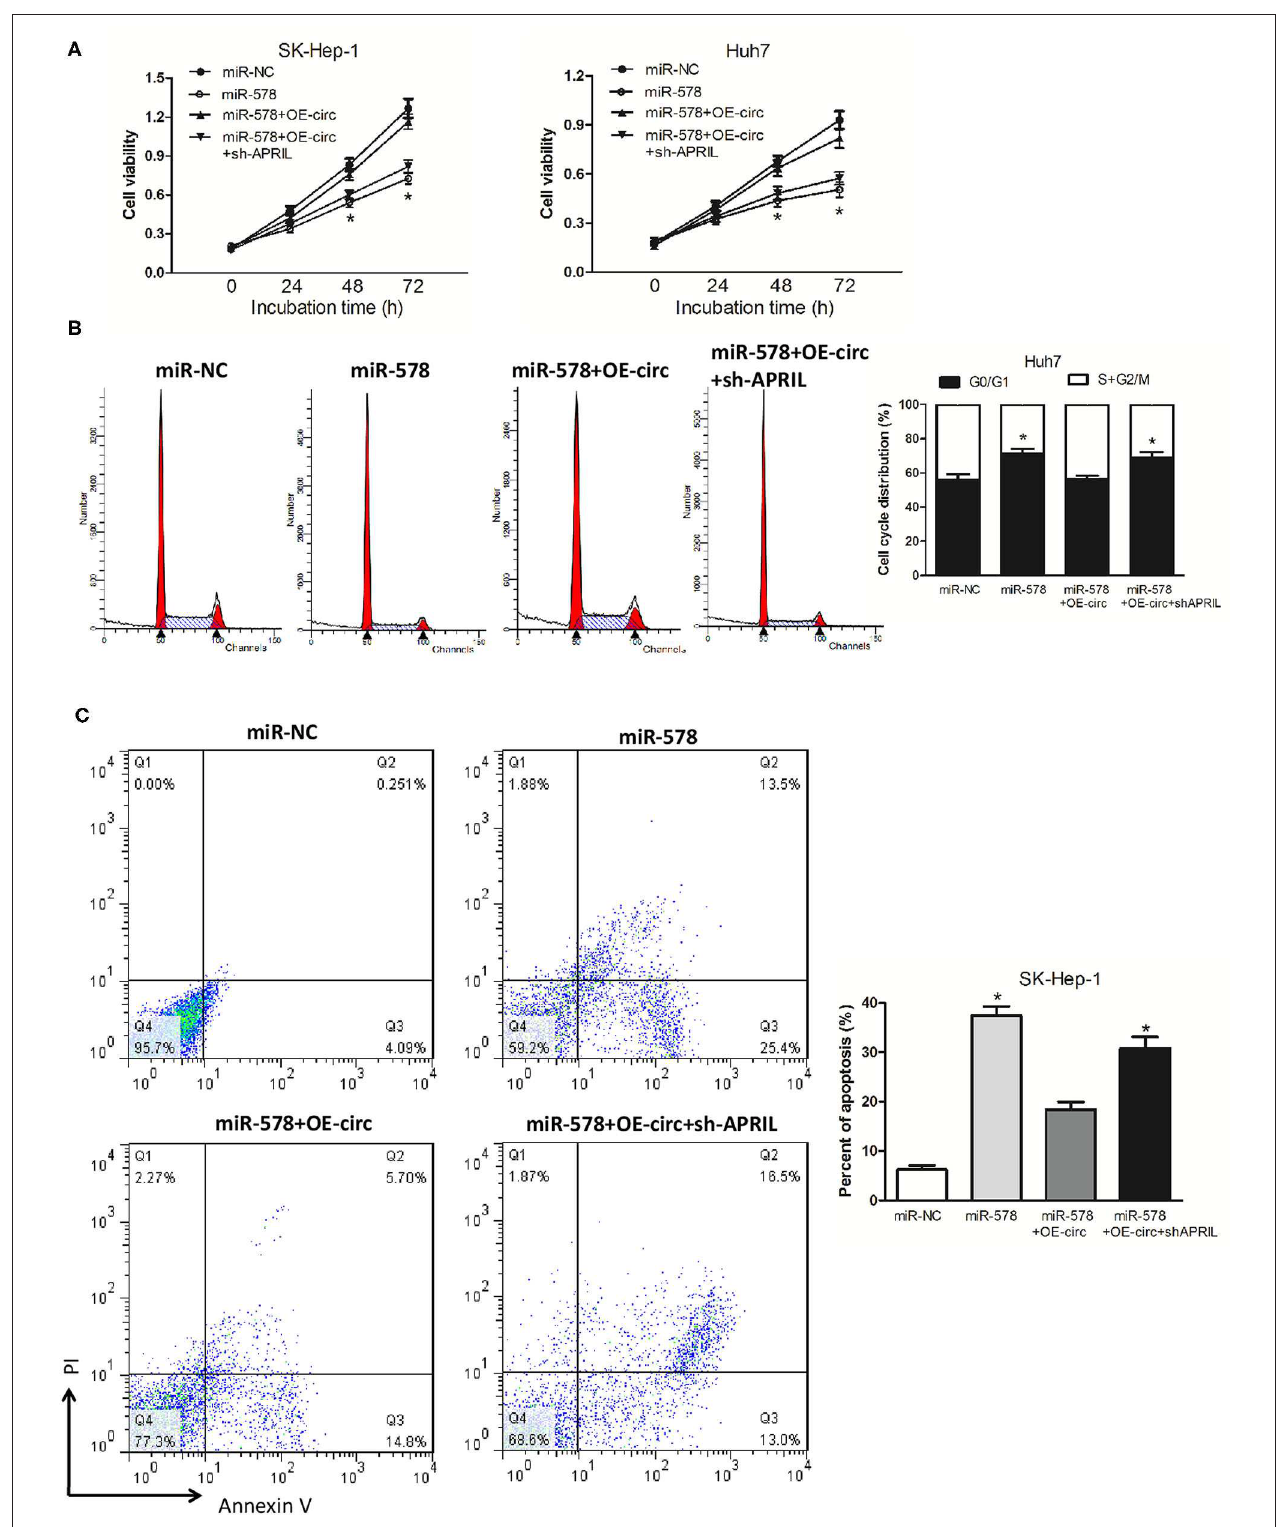
FIGURE 7 | hsa_circ_0005785 reverses the blocking effect of miR-578 on HCC cell growth. (A) Cell proliferation was determined in SK-Hep-1 and Huh7 cells after transfection with miR-NC, miR-578 mimic, miR-578 mimic + OE-circ, and miR-578 mimic + OE-circ + sh-APRIL by CCK-8 assay. Cell-cycle analysis in Huh7 cells (B) and cell apoptosis analysis in SK-HEP-1 cells (C) after transfection with miR-NC, miR-578 mimic, miR-578 mimic + OE-circ, and miR-578 mimic + OE-circ + sh-APRIL by flow cytometry. * P < 0.05.